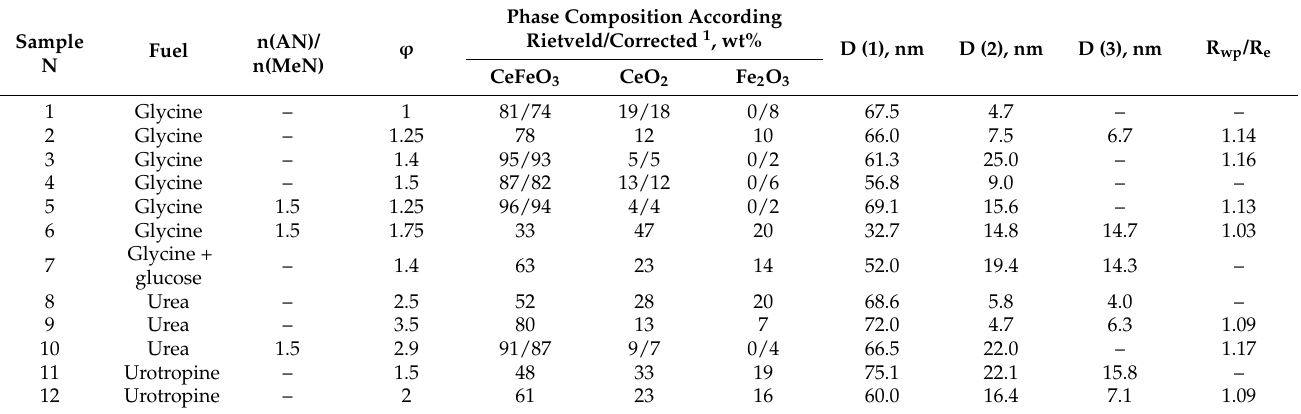
Table 1. Data on the phase composition and crystallinity of the synthesized materials according to the refinement by the Rietveld